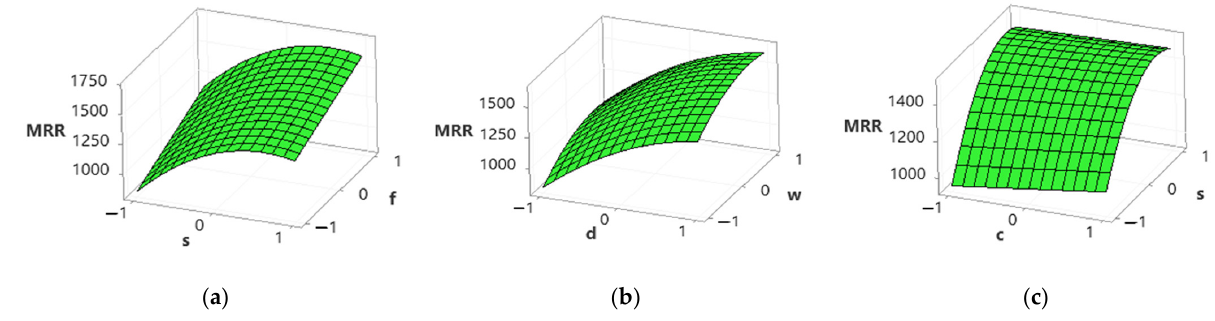
Figure 10. Surface plots for material removal rate. ( a ) Spindle speed vs. feed rate; ( b ) depth of cut vs. width of cut; ( c ) cutting conditions vs. feed